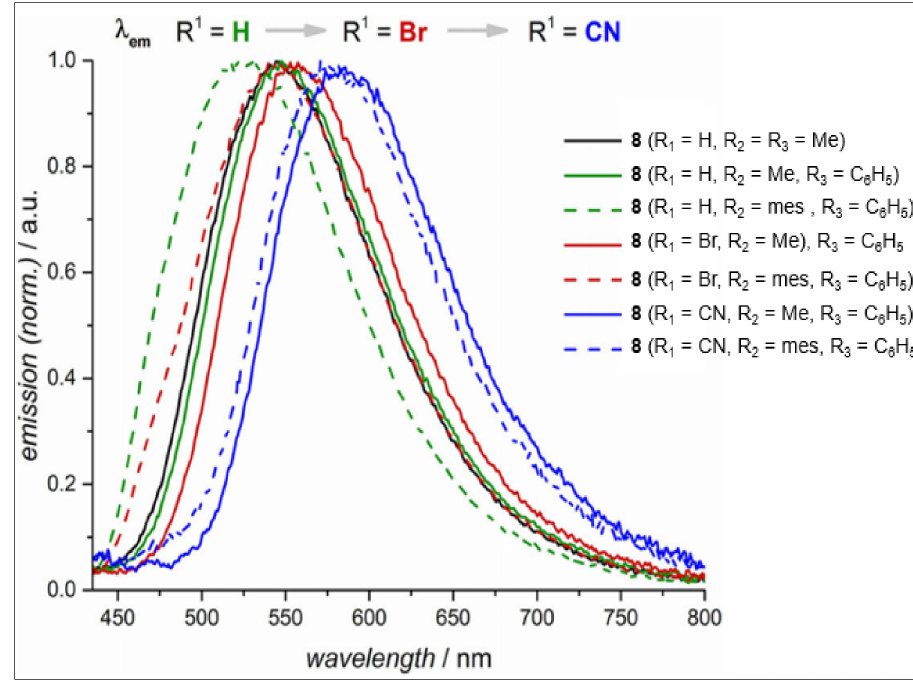
Figure 3. Emission spectra of complex 8 in PMMA matrix (2 wt% emitter load, λ exc = 360 nm) at room temperature. Reproduced with permission from ref.